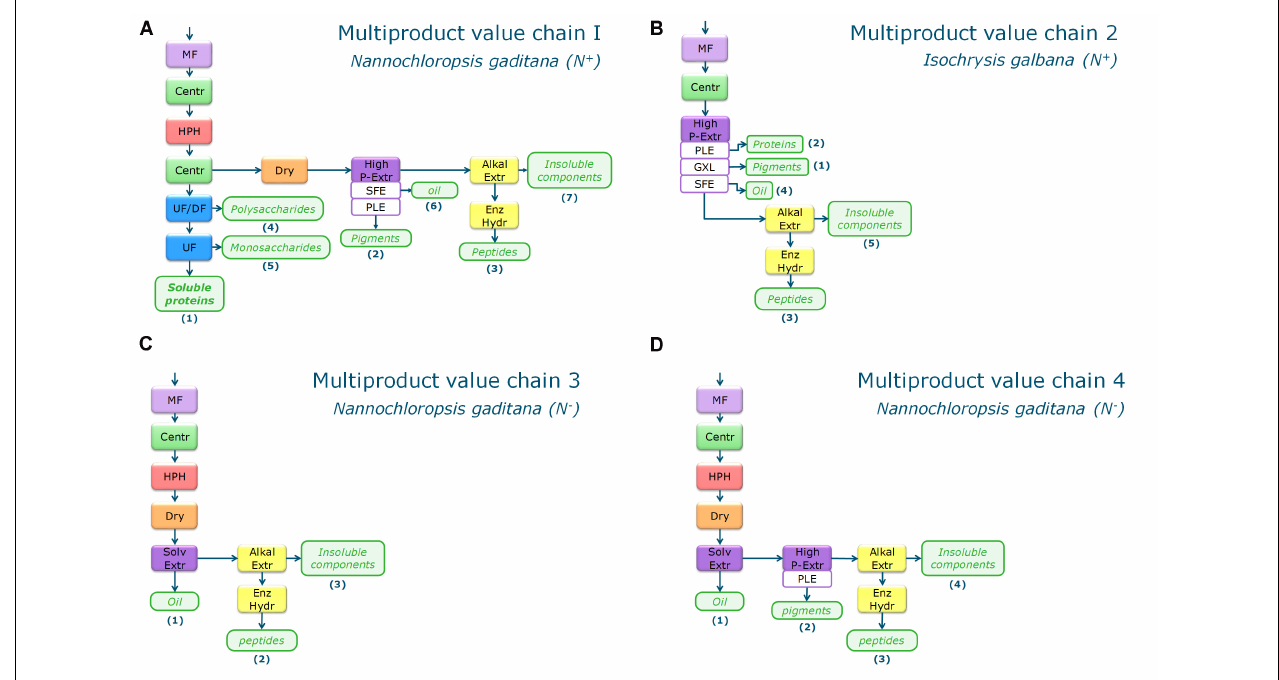
FIGURE 2 | Biorefinery process schemes for the four multiproduct value chains (A–D) . MP Chain 1 (A) and 2 (B) are based on N + -biomass, MP chain 3 (C ) and 4 (D) are using N - -biomass. MF, microfiltration; Centr, centrifugation; Dry, Spray drying; HPH, high pressure homogenization; UF, ultrafiltration; UF/DF, ultrafiltration/diafltration; High P–Extr, high pressure extraction (PLE, pressurized liquid extraction; GXL, gas expanded liquid extraction; SFE, supercritical fluid extraction), Alkal Extr, alkaline extraction; Enz Hydr, enzymatic